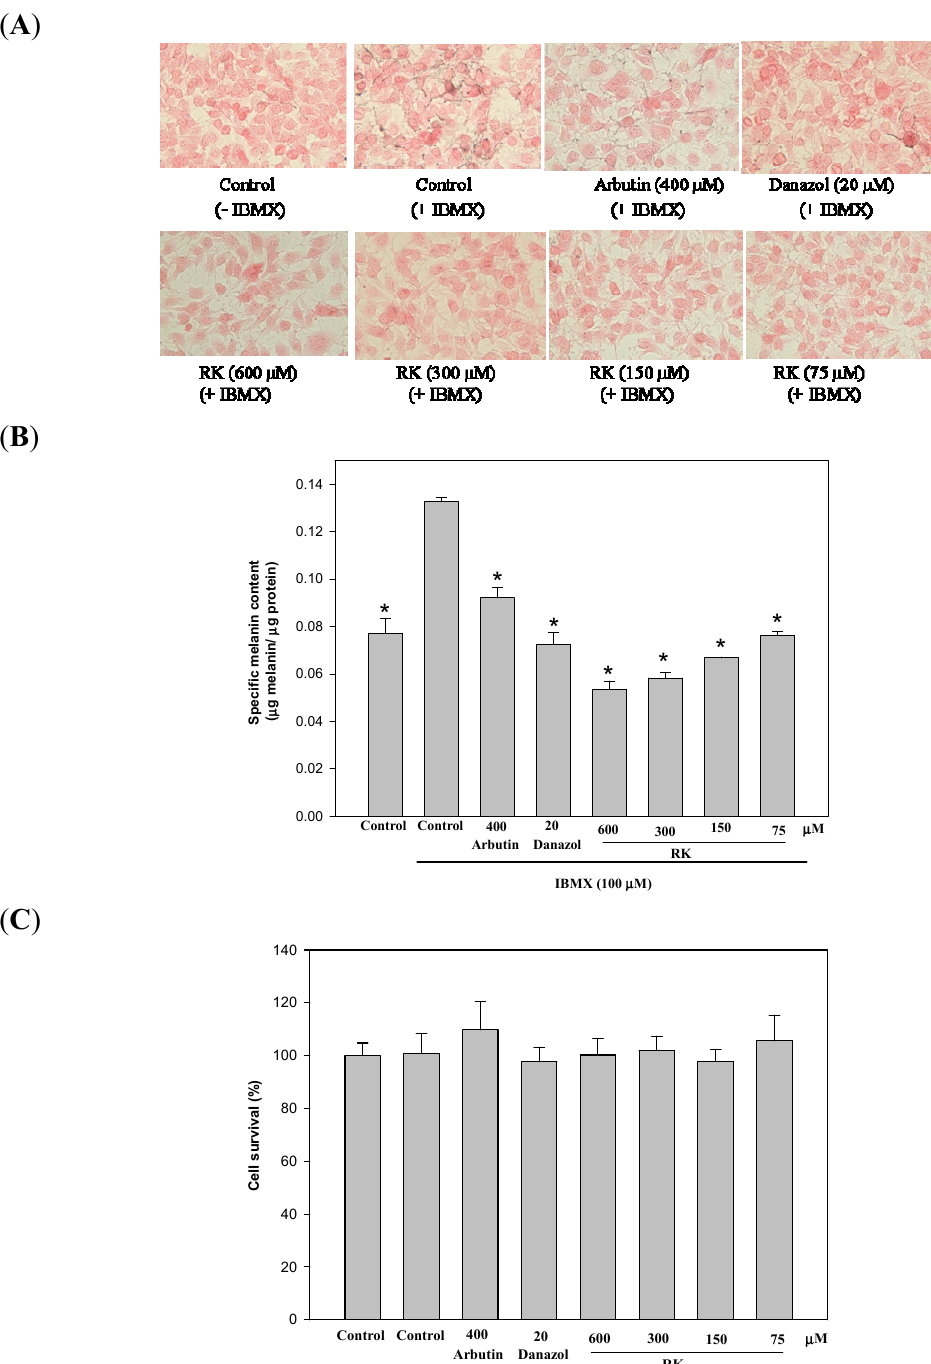
Figure 2. Effects of RK on Melanogenesis ( A , B ) and Cell Survival ( C ) in B16 Cells. The cells were cultivated for 1 d and then stimulated with 100 µM of IBMX for 2 d with various concentrations of RK. The melanin content of the cells was determined by Fontana-Masson staining (A) and spectrometry (B), as described in the Experimental Section, and cell survival was determined by the MTT method (C). Averaged data (n = 3) are presented with error bars indicating SD. A value of p < 0.001 (*), obtained with a Student’s t -test by comparing the data with those for the IBMX-stimulated control, was considered statistically